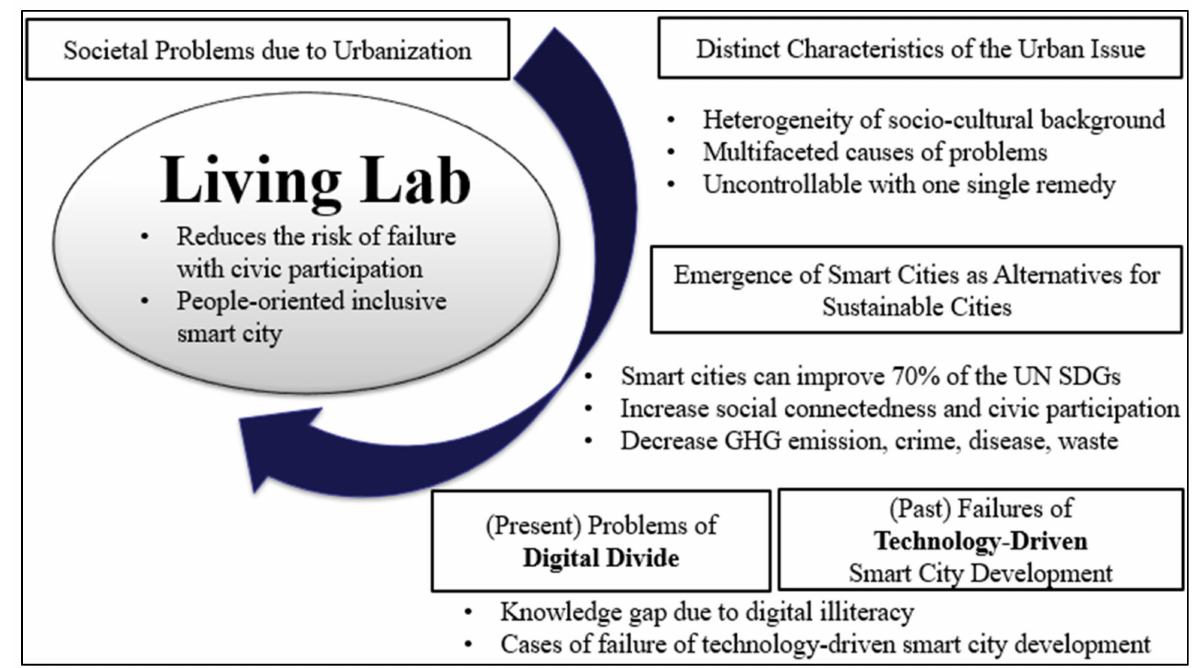
Figure 1. Research flow from the smart cities and living